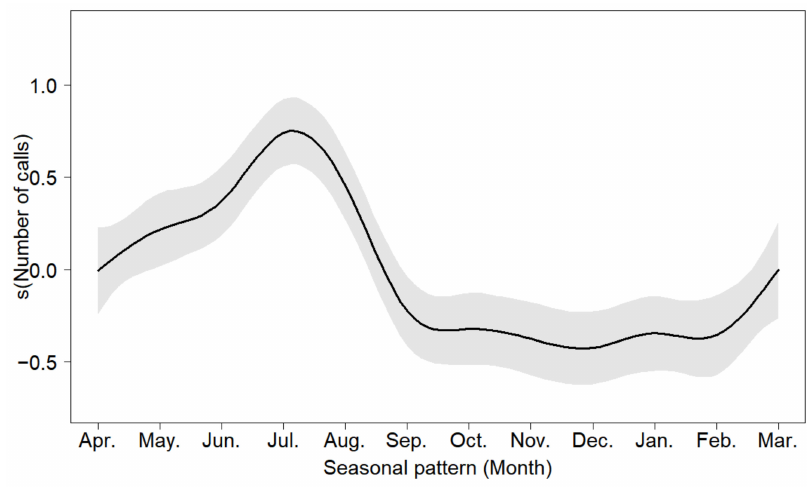
Figure 4. Seasonal vocal activity of the Oriental Turtle Dove. The gray shaded part represents the associated 95% confidence intervals.